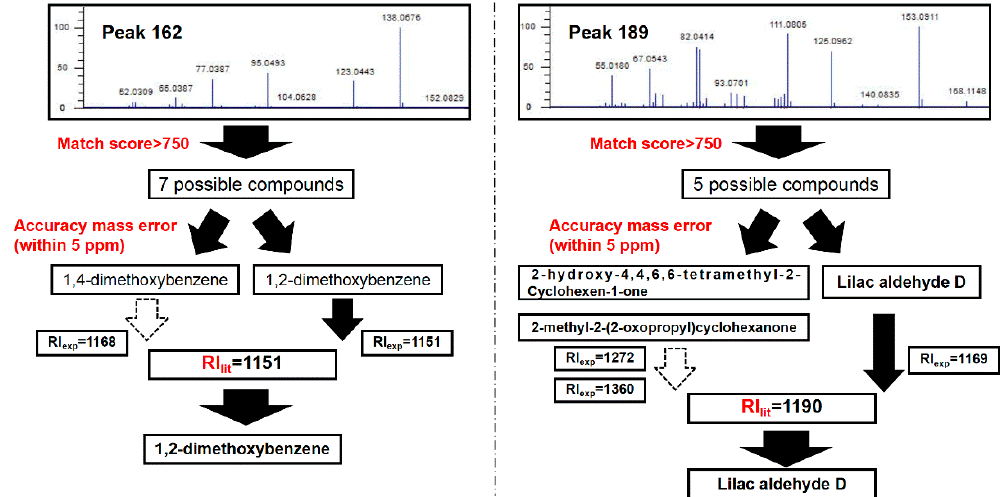
Figure 2. Diagram illustrating the process of compound confirmation in GC×GC-QTOFMS.